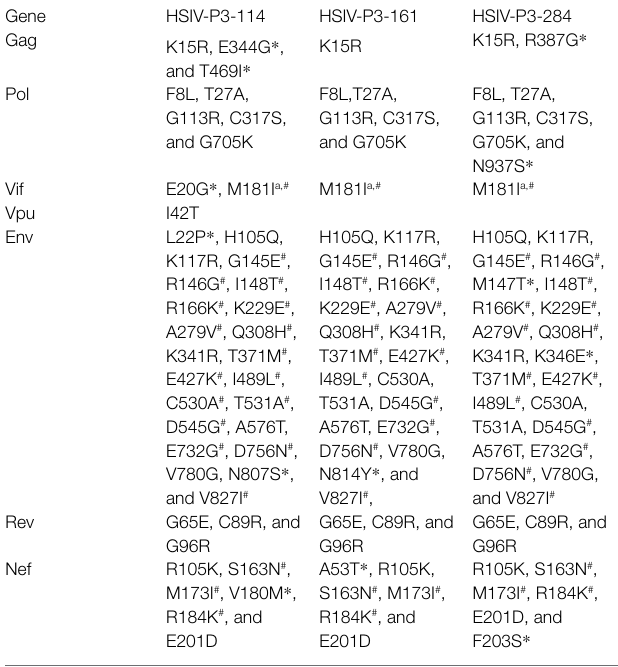
TABLE 2 | Nonsynonymous mutations observed in HSIV-P3 infectious molecular clones (IMCs).